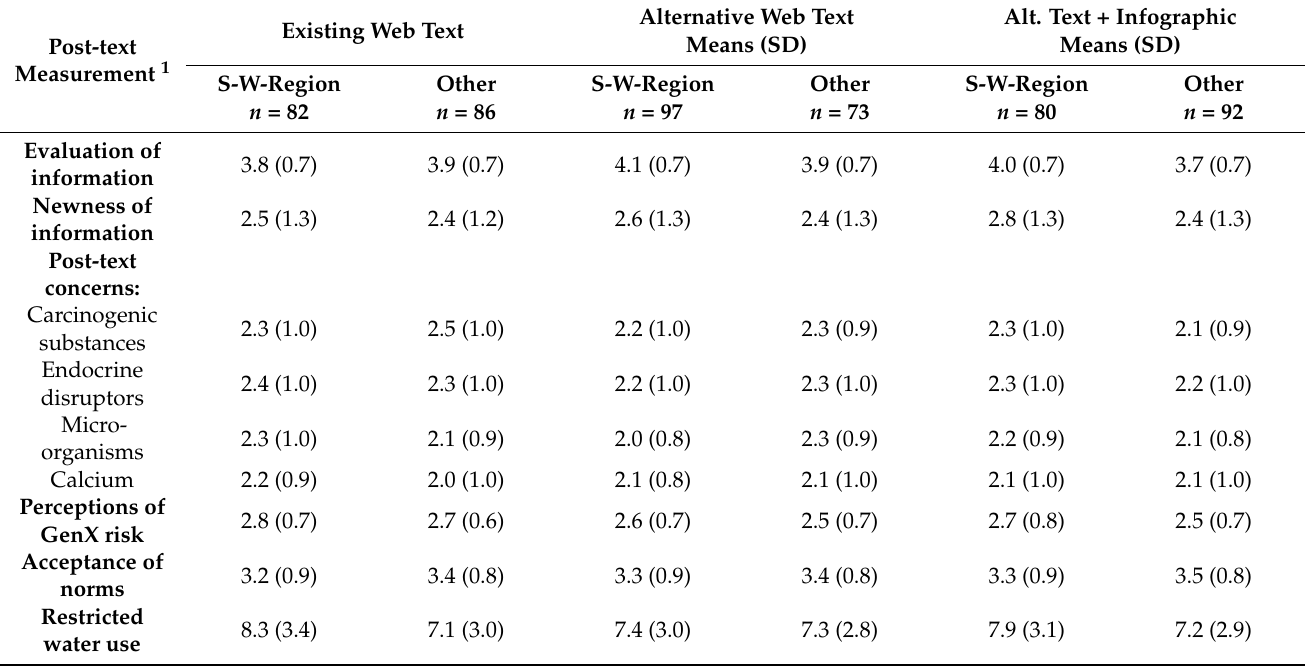
Table 5. Post-text outcomes per condition and